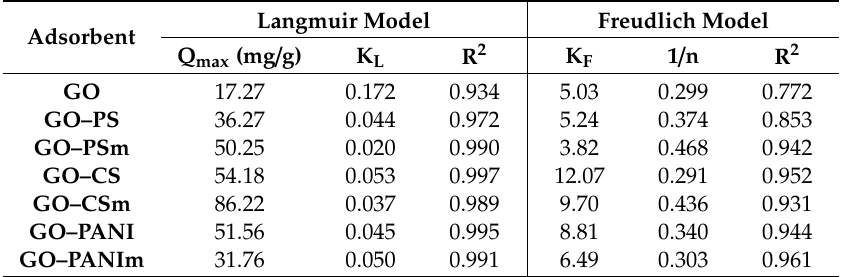
Figure 11. Isotherms of adsorption of BPA onto GO composites (compact lines for Freundlich equation fitting, dashed lines for Langmuir equation fitting.). Table 3. Equilibrium parameters for the adsorption of BPA on GO-polymer composites.